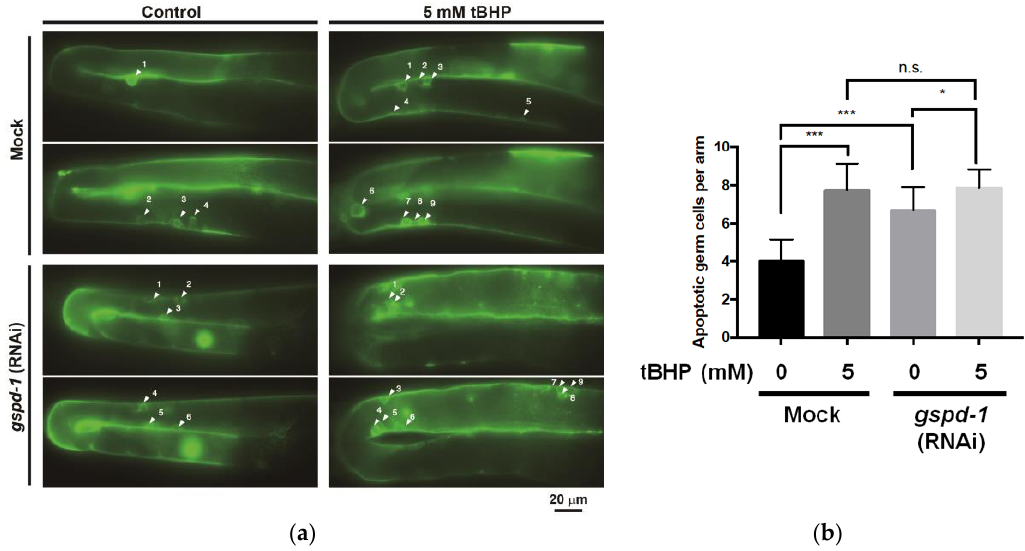
Figure 3. Short-term of tBHP administration on young adults of mock and gspd-1 - knockdown C. elegans promoted germ cell apoptosis. ( a ) Fluorescent micrographs of apoptotic germ cells (white arrowheads) in the gonad of mock and gspd-1 -knockdown C. elegans with or without 5 mM tBHP (scale bar 20 µm). ( b ) Mean apoptotic germ cells. Data from three independent experiments are shown